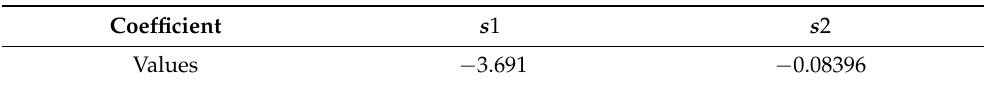
Table 3. Empirically identified parameters used to predict module back surface temperature using sandia model.